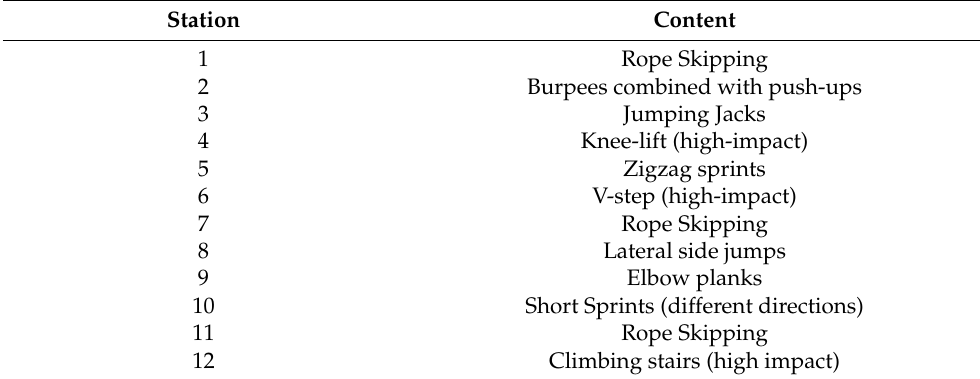
Table A3. Content CIRCUIT